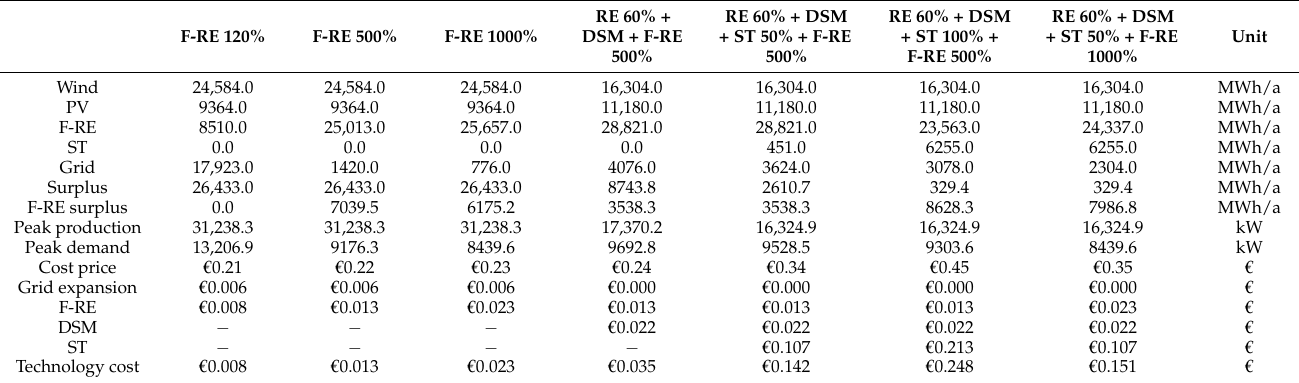
Table A25. Results from the BioMAX